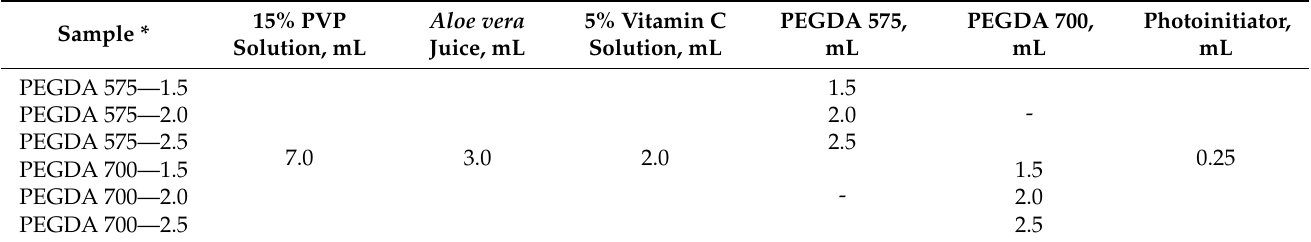
Table 2. Compositions of the hydrogels. Table 2. C ompositions of the hydrogels.